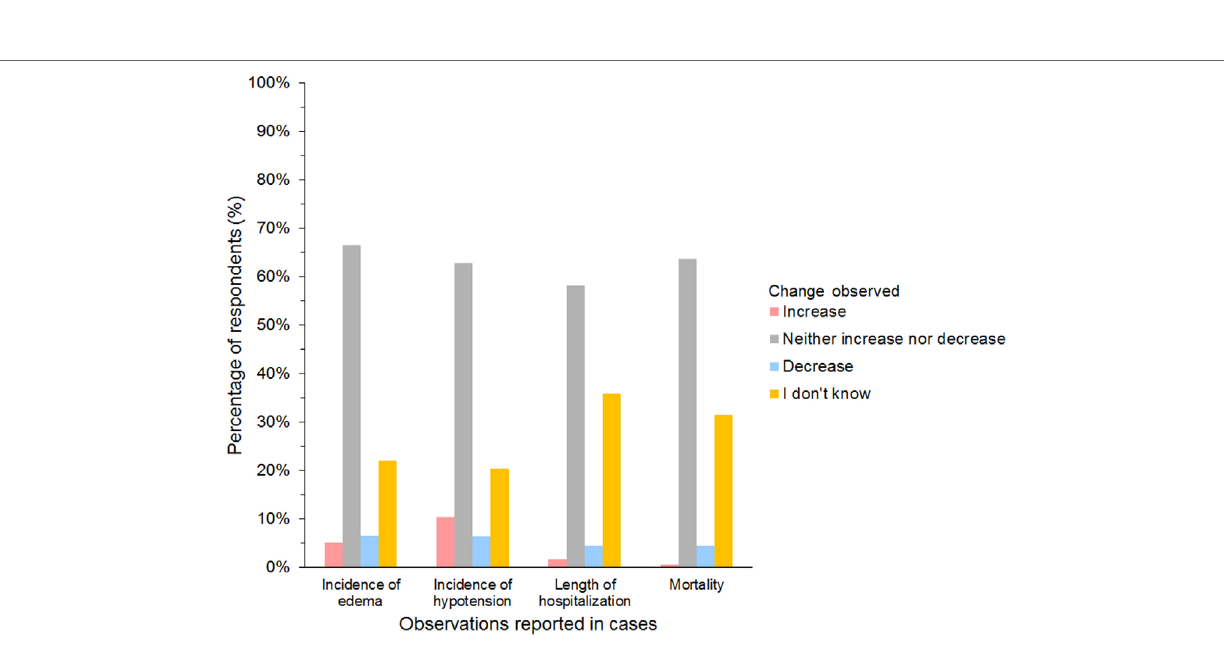
FigUre 11 | Frequency chart showing incidence of adverse reactions noted by survey respondents since changing their use of synthetic colloids (654 hydroxyethyl starch users; 27 gelatin users; 12 dextran users).